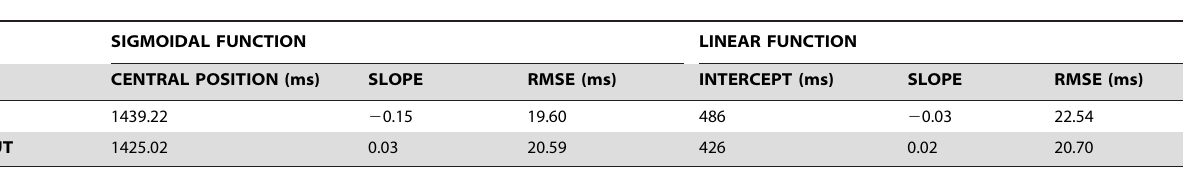
Table 1. Estimated parameters and Root Mean Square Errors for the sigmoidal function (central position and slope, on the left) and the linear function (intercept and slope, on the right) fitting the relationship between tactile RTs and timing of touch delivery 2 300 ms, 800 ms, 1500 ms, 2200 ms, 2700 ms, corresponding to the five different perceived positions of the sounds - both for IN and OUT sound.